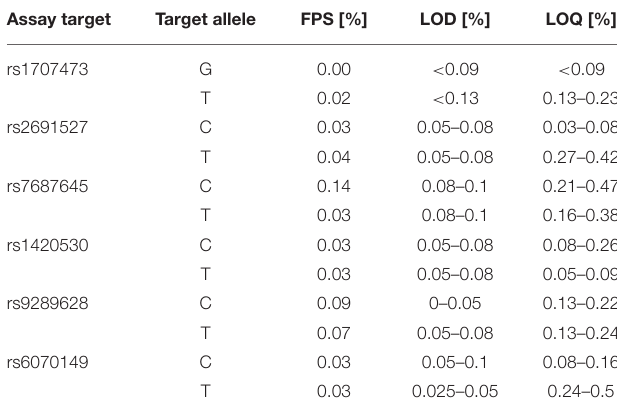
TABLE 2 | Characteristics of SNP ddPCR assays defined by measuring copies of alleles in mixtures of gDNA/gBlocks with a background of 50,000 copies of major alleles per ddPCR